Question: What visual encoding does this figure use to show its data?
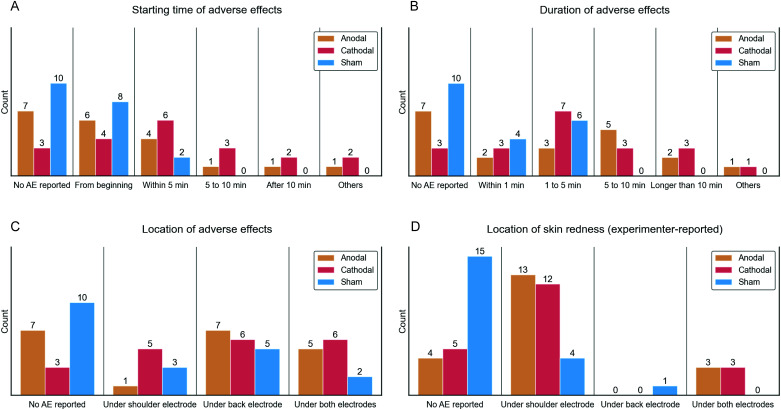
Answer: bar